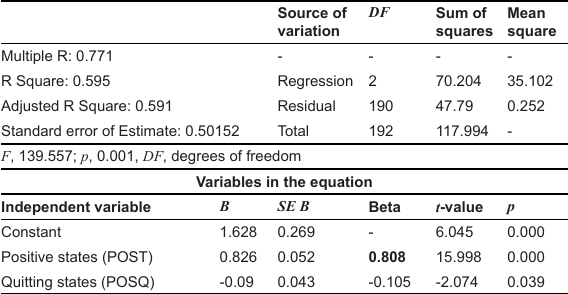
Multiple regression of positive states on entrepreneurship orientation factor ii (dv)